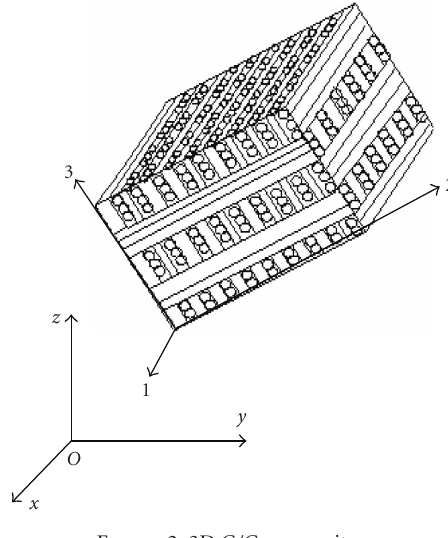
Figure 2: 3D C / C